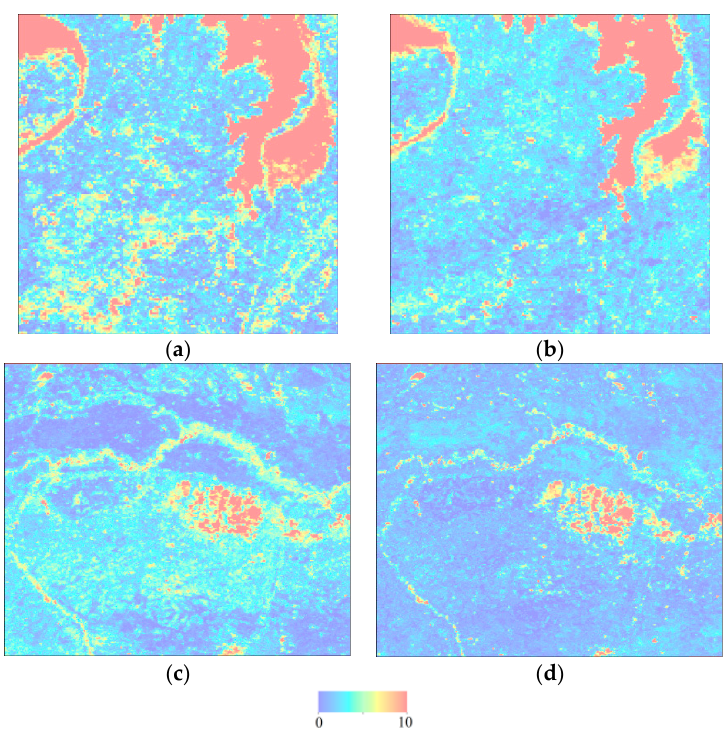
Figure 8. OLWDTW distance with the best selected value of σ in the two test sites: ( a ) is the single cropping rice paddy in test site 1; ( b ) is the double cropping rice paddy in test site 1; ( c ) is the dryland crop 1 in test site 1; and ( d ) is the dryland crop 2 in test site 1.